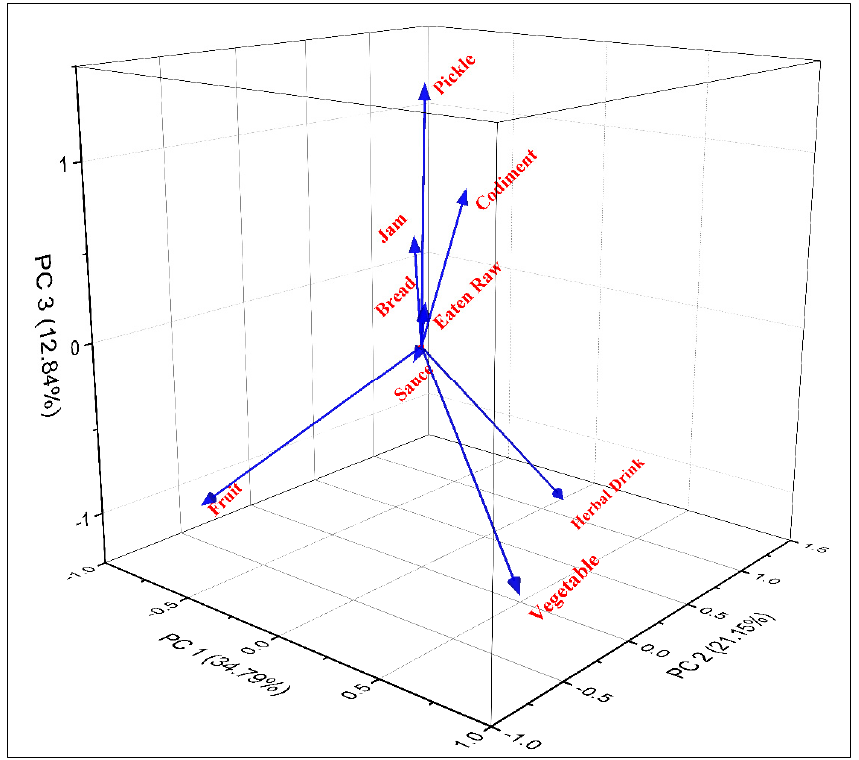
Figure 3. Principal Component Analysis (PCA) biplot of different food categories in the semi-arid region of Indo–Pak border.